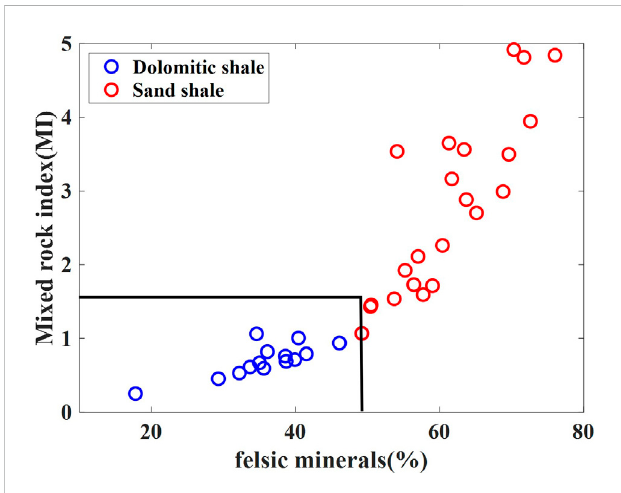
The relationship plot between MI and felsic minerals content.